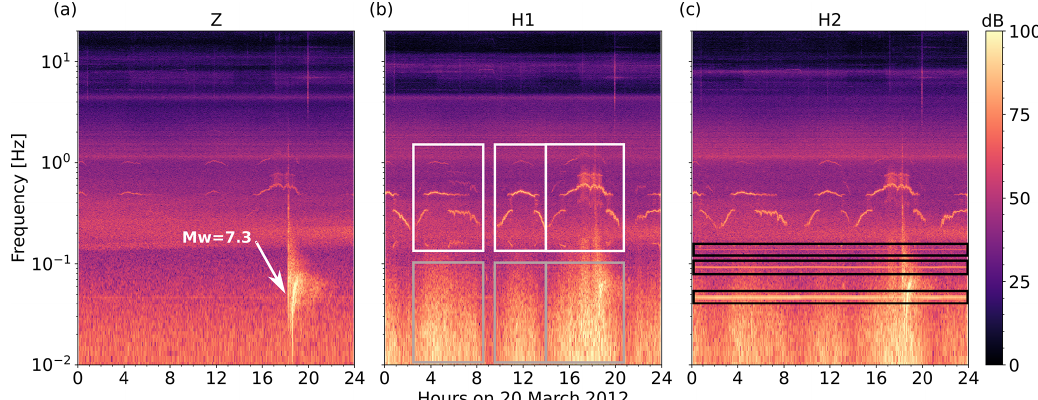
Figure 1. Spectrogram of a 1d OBS signal showing ocean bottom noise on Z (a) , H1 (b) , and H2 (c) components. The data were recorded by the station D10 of the DOCTAR array with a sampling frequency of 100Hz. The spectrograms were calculated using a window length of 2 16 samples and an overlap of 75%. The signal of an earthquake ( M w = 7 . 3) on 20 March 2012 at around 18:00 at the station D10 is shown in (a) . The tidal cycle of the current-induced noise is clearly visible during the high-tilt-noise episodes (gray box in b ). The white box in (b) highlights the tremor episodes caused by the head buoy strumming. On H2 (c) we see instrument-related, presumably electronic noise (black boxes). The high energy of the secondary microseism band at around 0.2Hz is visible on all